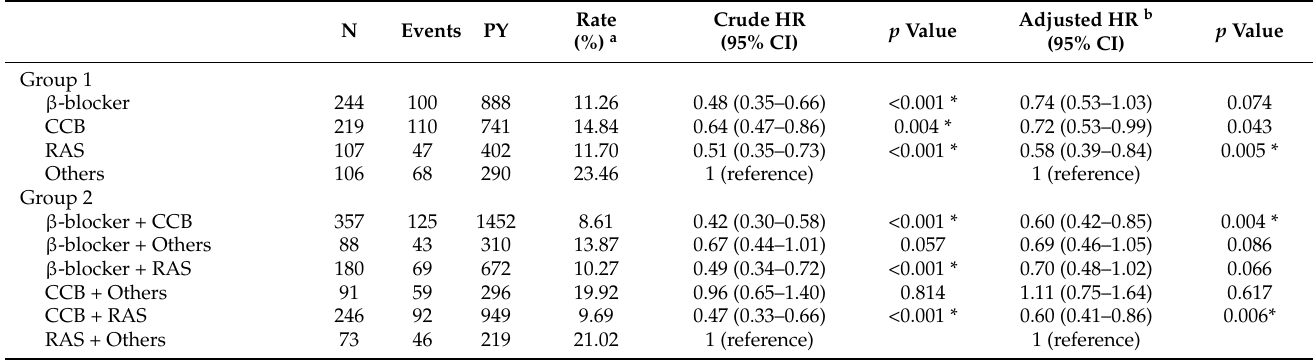
Table 3. Univariable and Multivariable Cox Proportional Hazard Model Analysis for Composite